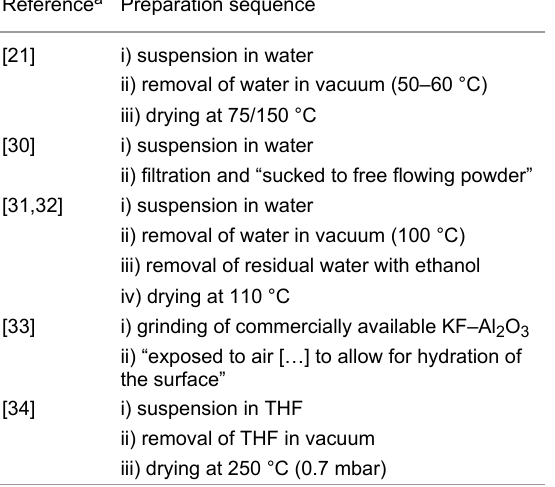
Table 1: Representative experimental procedures for the preparation of KF–Al 2 O 3 . Reference a Preparation sequence